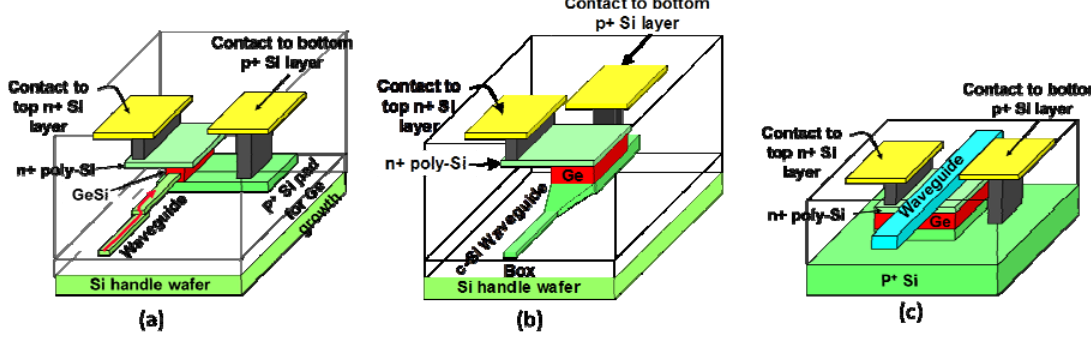
Figure 8. Schematic structures of typical waveguide-integrated Ge active photonic devices. ( a ) butt-coupled; ( b ) Evanescent coupling with waveguide at the bottom of the Ge photonic device; ( c ) Evanescent coupling with waveguide on top of the Ge photonic device [18].